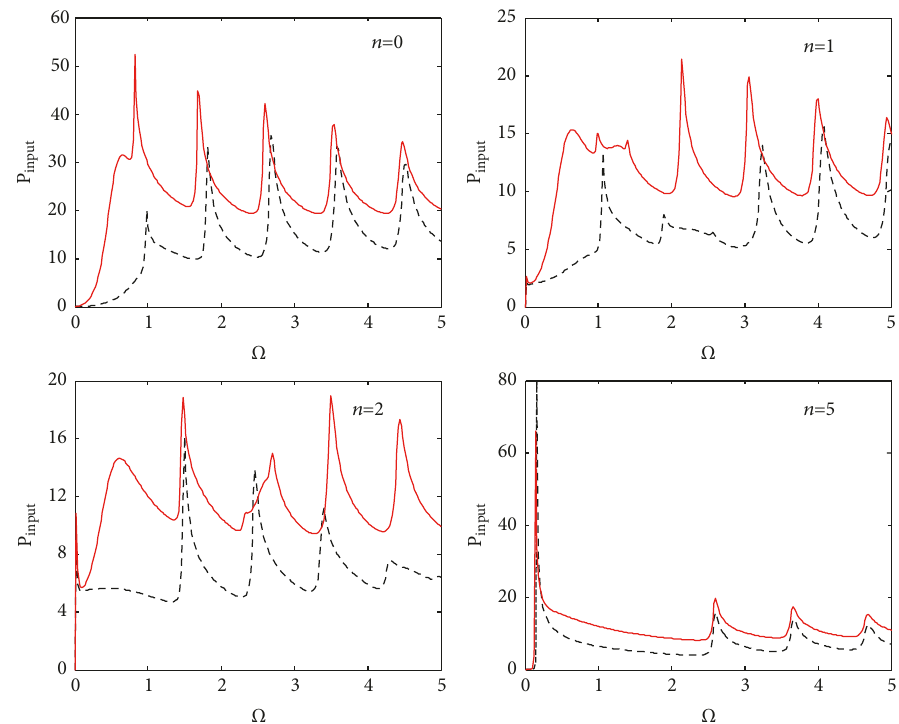
Figure 8: The comparison of nondimensional input power flow into the shell with 𝐸 11 /𝐸 22 = 15 ; black dashed line: 𝐸 11 /𝐸 22 = 15 ; red solid line: 𝐸 11 /𝐸 22 = 2.5